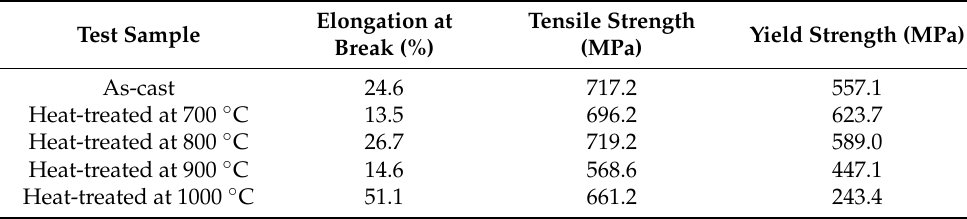
Table 3. Tensile properties of FeCrMnNi alloy heat-treated at different temperatures.